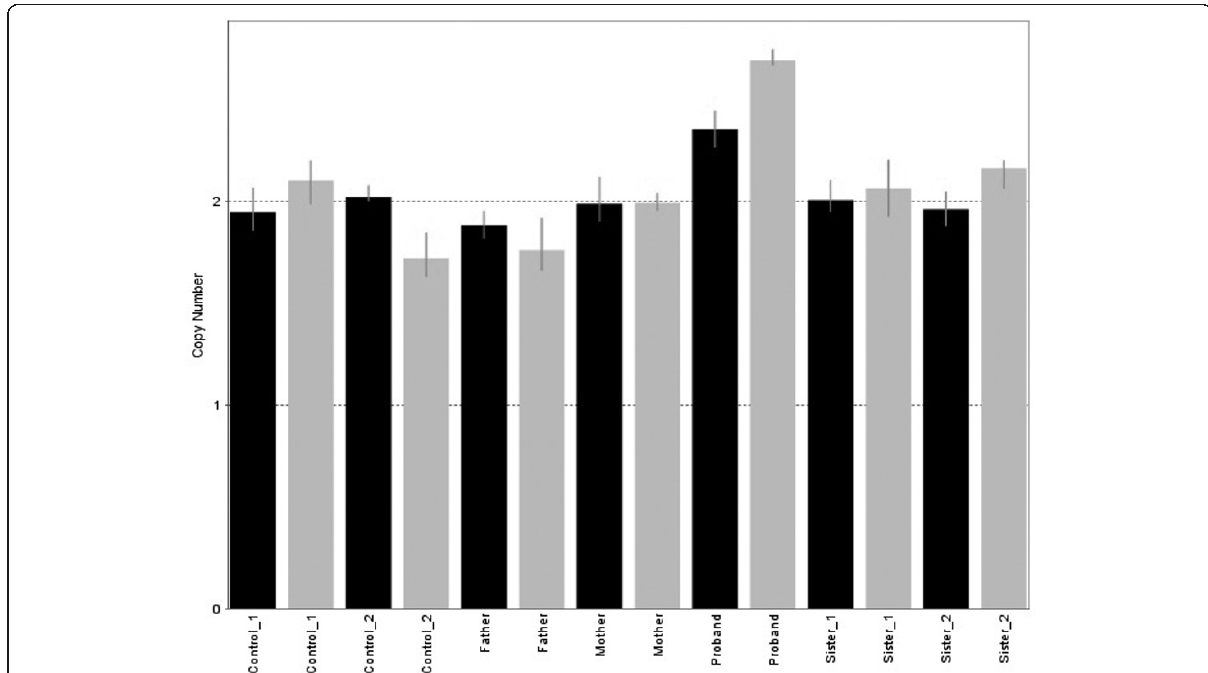
Figure 4 Copy number of the ZFPM2 gene in the proband, her mother, father, two sisters and two control samples . Each bar represents the copy number prediction of the target sequence in each subject and different colors correspond to each copy number assay (grey: Hs02556672_cn, black: Hs06234652_cn). Thus, each individual is represented by two bars. The broken line indicates the reference line for two